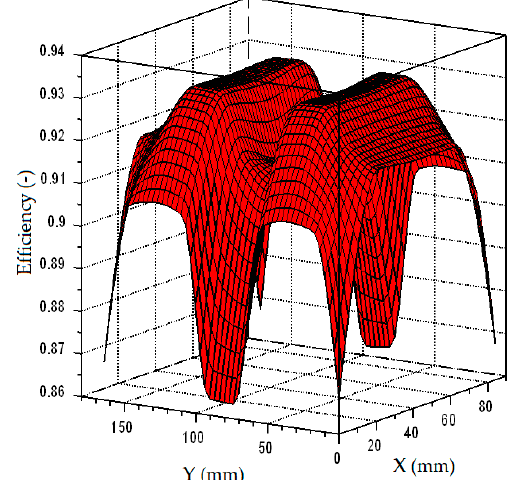
Figure 10. The 3D plot of the total efficiency as a function of the relative position of the receiver.